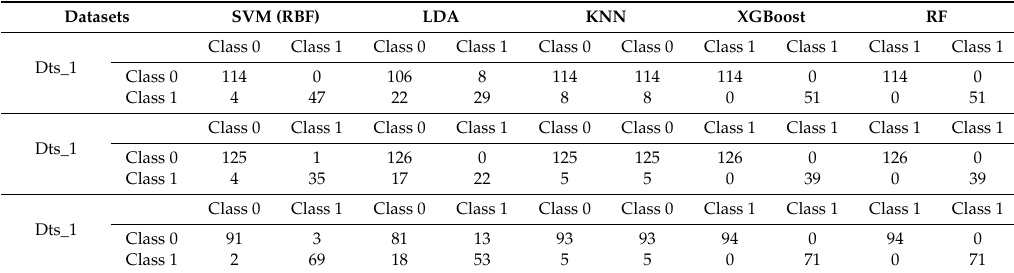
Table 8. Confusion matrices of generated results using all